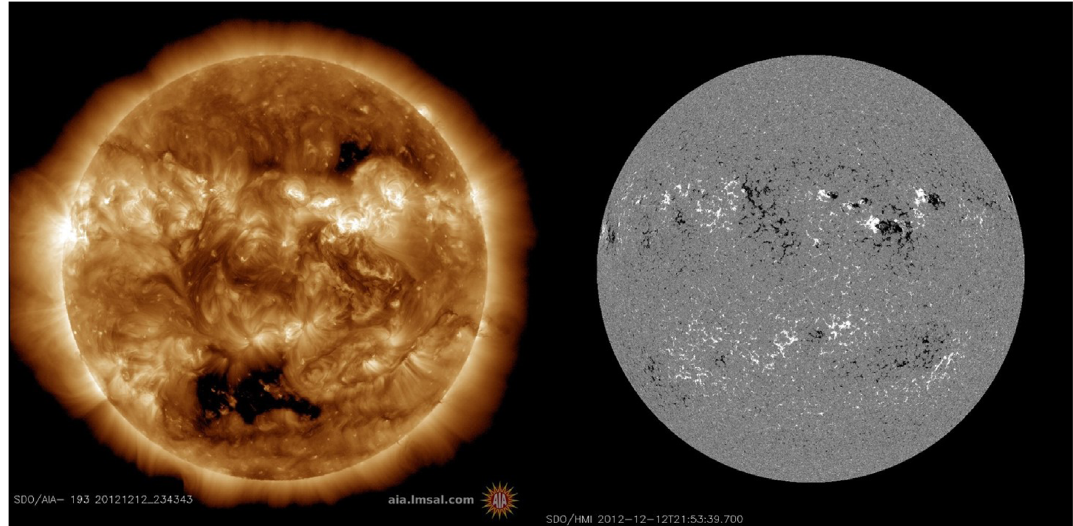
Fig. 1. 12 December 2012; (left) 193 Å passband image from SDO /AIA showing the magnetically-dominated coronal EUV emission, and (right) the surface magnetic fi eld from the